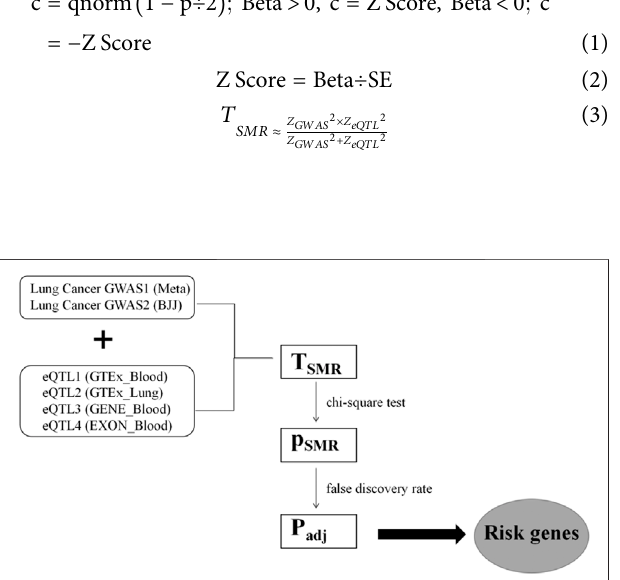
FIGURE 2 | The process of GWAS and eQTL conjoint analysis. The two GWASdatasets oflung cancerwerecross-analyzedwithfour groupsofeQTL datasets. Signi fi cance of gene expression was found after T SMR calculation, chi-square test, and FDR correction.